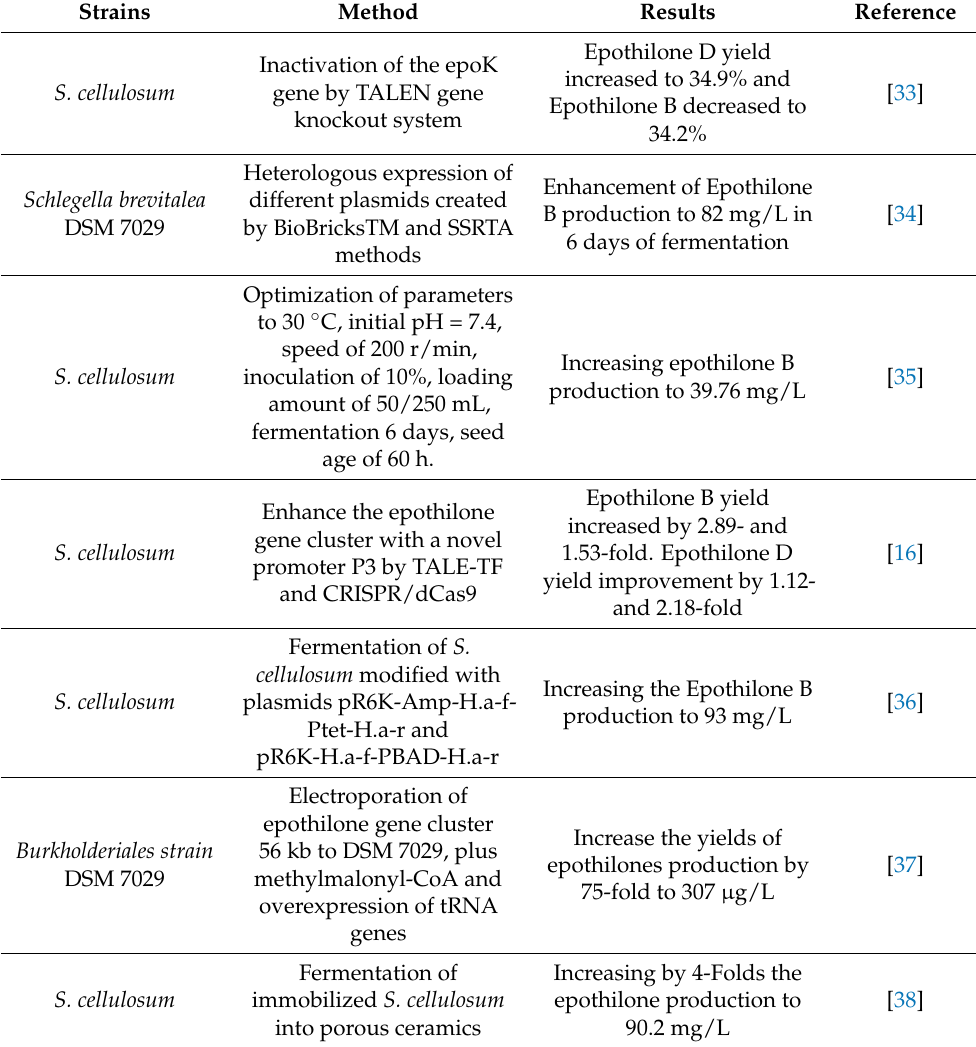
Table 1. Selected biotechnological methods in epothilone